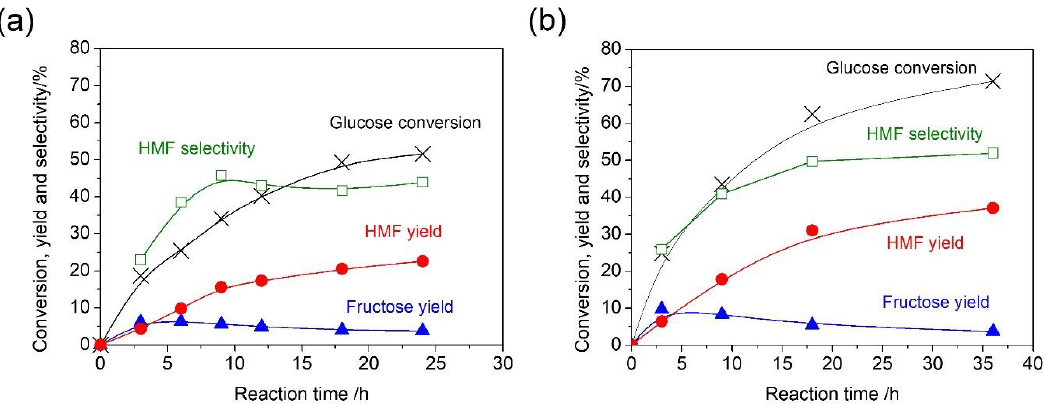
Figure 2. Time course of HMF formation from glucose over HNbWO 6 aggregated nanosheets. Reaction conditions : ( a ) glucose (50 mg), catalyst (50 mg), water (3 mL), 393 K. ( b ) glucose (50 mg), catalyst (50 mg), water (3 mL), 1-butanol (3 mL), 393 K.